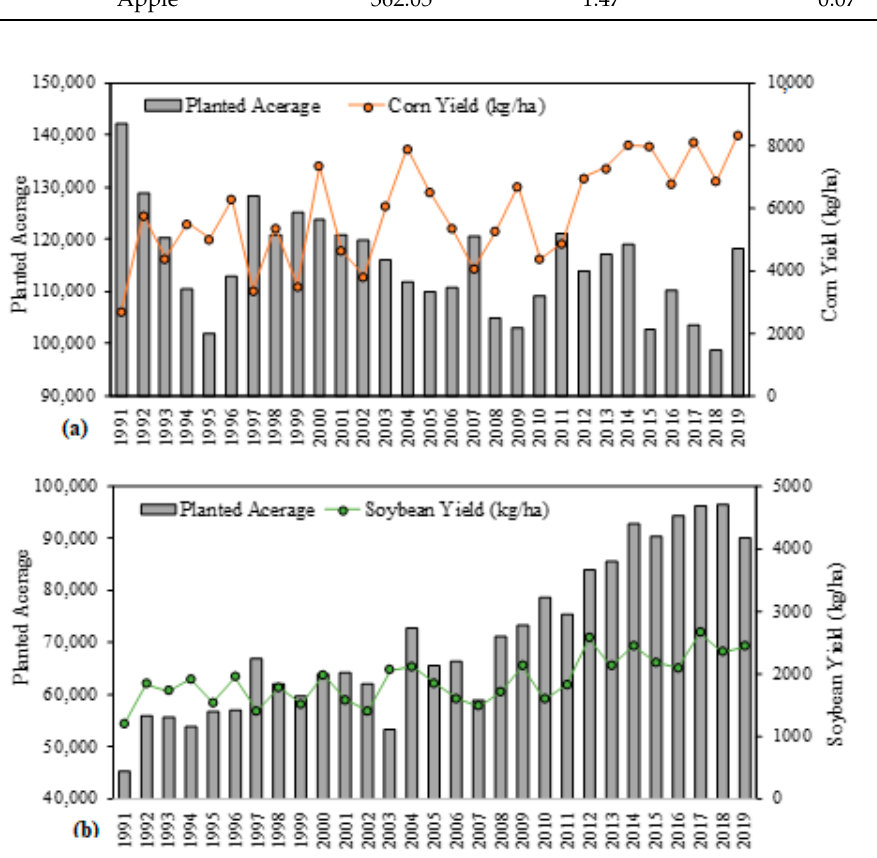
Figure 2. Historical crop yield and planted acreage for ( a ) corn and ( b ) soybean. Data collected from United States Department of Agriculture (USDA) National Agricultural Statistics Service (USDA–